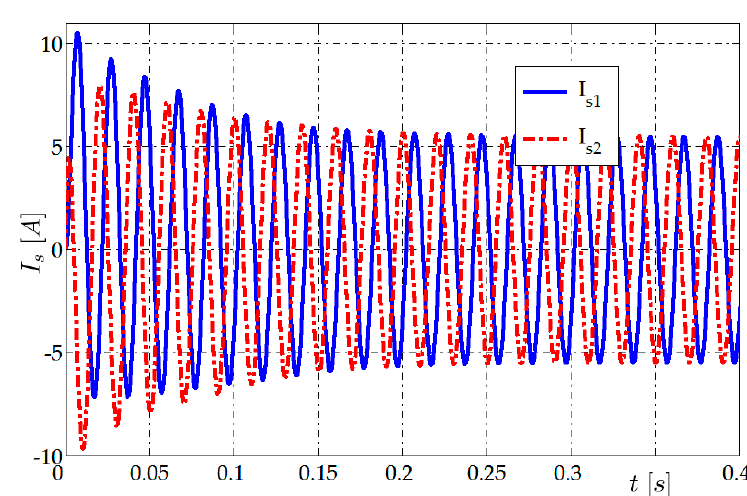
Figure 10. The phase currents in the stator windings during the start-up motor for load torque 15 Nm. The electric torque during the start-up motor for the di ff erent load torque values is presented in Figure 11.